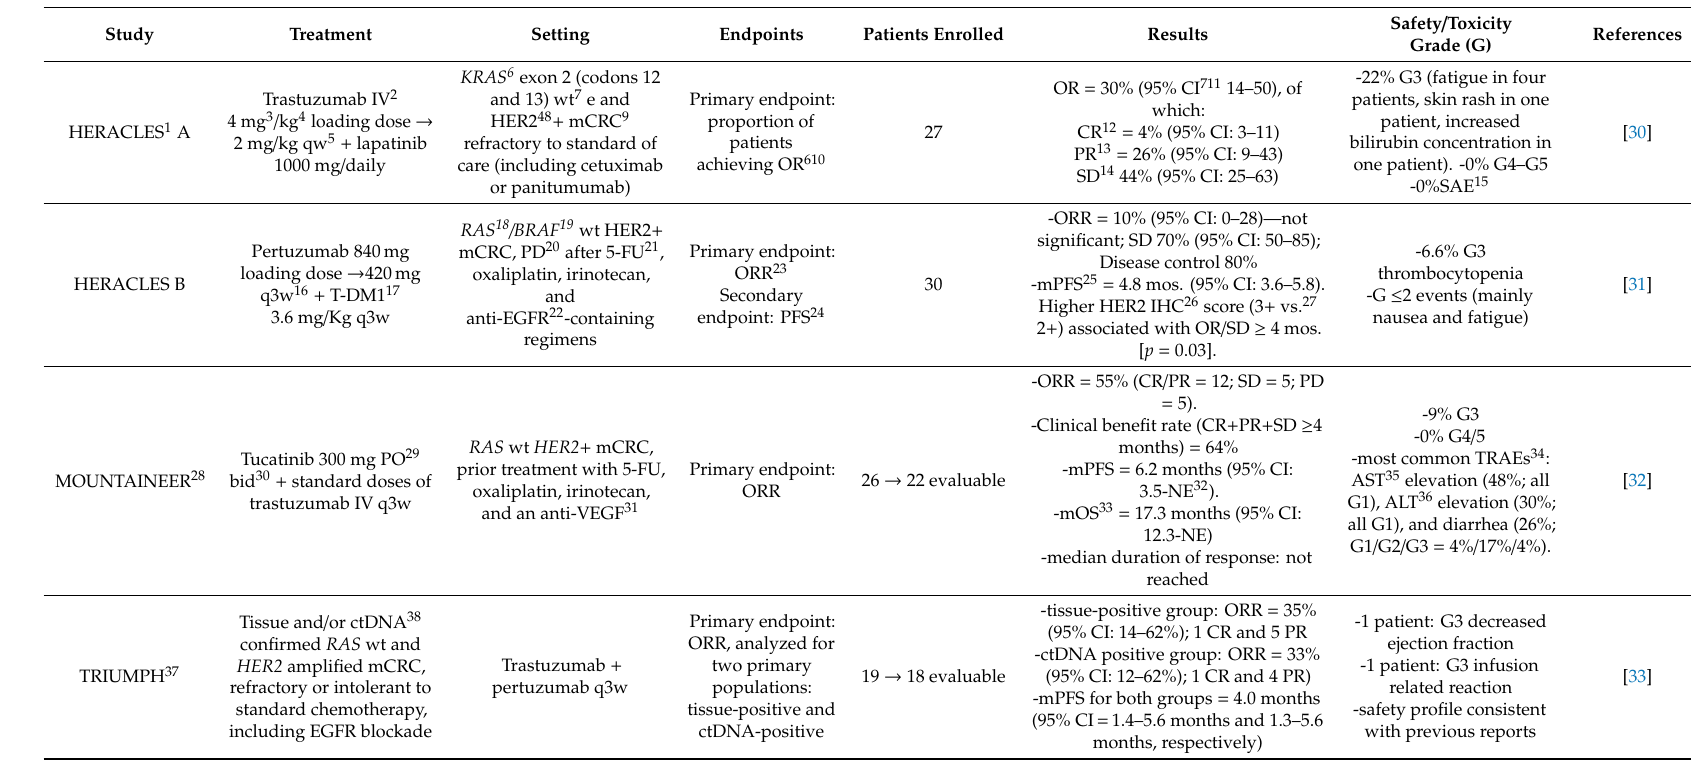
Table 2. Anti-human epidermal growth factor receptor 2 (HER2) treatment strategies—phase II